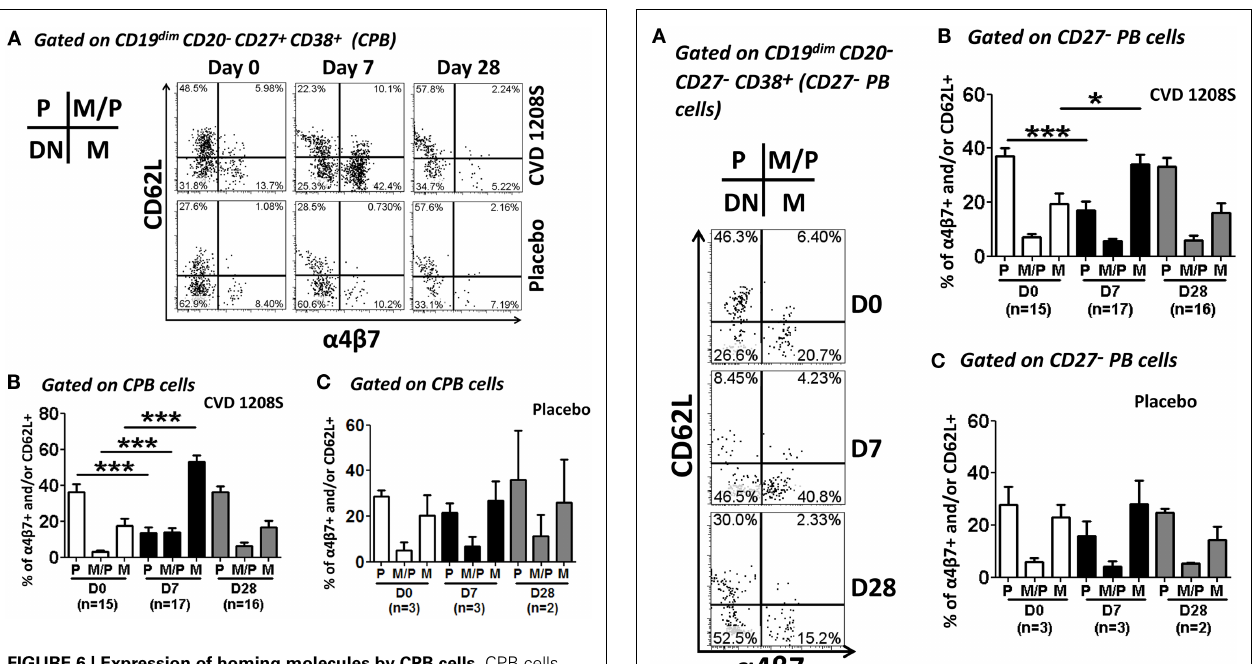
FIGURE 6 | Expression of homing molecules by CPB cells . CPB cells [CD19 dim CD20 − CD27 + (high) CD38 + (high) ] were gated as described in Figure 5 CPB cells were assayed for the expression of integrin α 4 β 7 and CD62L to evaluate their homing potential. (A) Representative example of the changes in integrin α 4 β 7 and CD62L expression in CPB cells at different time points (days 0, 7, and 28) in vaccine (top 3 panels) and placebo (bottom three panels). (B,C) Compiled data of the expression of homing receptors in CPB cells in vaccine and placebo recipients, respectively. Bars indicate arithmetic mean ( ± SEM).White, black and gray bars indicate days 0, 7, and 28, respectively. Horizontal lines indicate groups compared and asterisks indicate statistical significance (*** p < 0.0005). In the inset: P indicates cells expression of CD62L only. M indicates expression of integrin α 4 β 7 only. M/P indicates co-expression of integrin α 4 β 7 and CD62L.